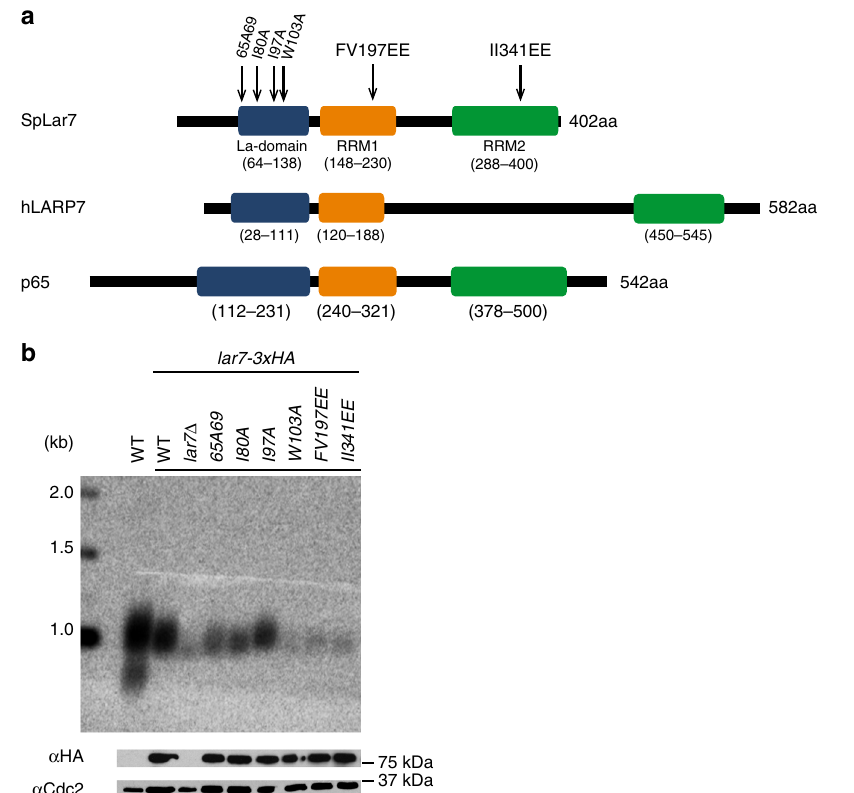
Fig. 2 Lar7 is an RNA-binding protein of the LARP7 family. a Schematic representation of the predicted La-domain and RNA-recognition motifs (RRMs) in S. pombe Lar7. Amino acid numbers of each domain are stated in brackets. Strains with the Lar7 point mutations indicated were made for further study. Lar7 is aligned with hLARP7 and p65 based on a position of each domain. b Telomere southern blot of six lar7 mutant strains. Western blot (probing with α -HA) con fi rms stability of each mutant protein. Original blot image is shown in Supplementary Fig. 4. Cdc2 was used to control for sample